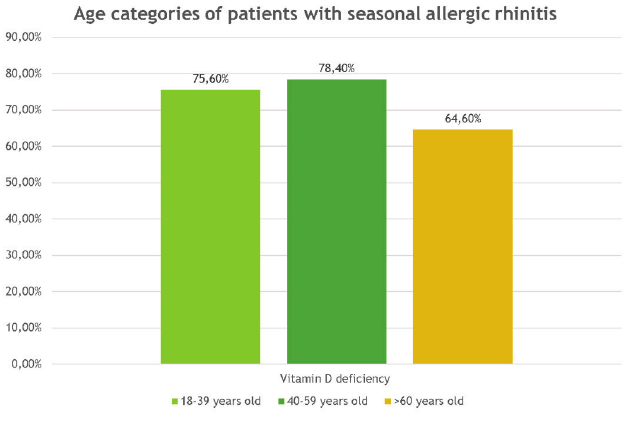
Figure 5c - correlation the sneezing with vitamin D concentration